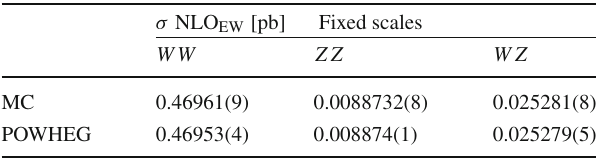
Table 5 Integrated cross sections for the processes pp → e + ν e μ − ν μ , pp → μ + μ − e − e + , and pp → μ + ν μ e − e + at NLO EW under the event selection in Eqs. (10) and (11). The factorization scale is set to μ = ( M OS + M OS )/ 2, ( V , V (cid:3) = W , Z V V (cid:3)